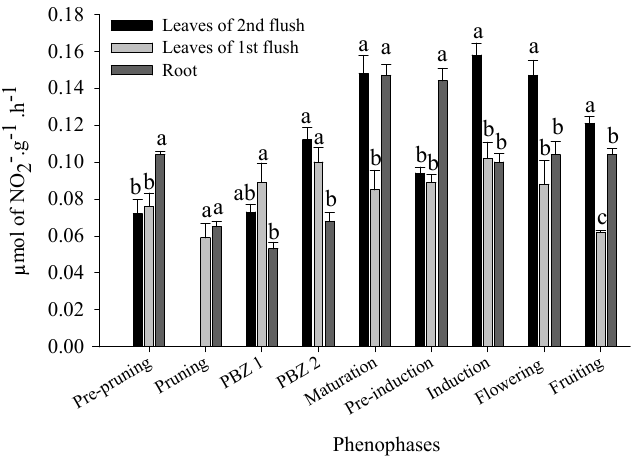
Fig. 2: Nitrate reductase activity in leaves of the 1 st and 2 nd vegetative flush - es and young roots of ‘Palmer” mango along different phenophases. Means ± SD followed by the same letters on the bars, into each phe- nophases singly, do not differ significantly by the Tukey test at 5%